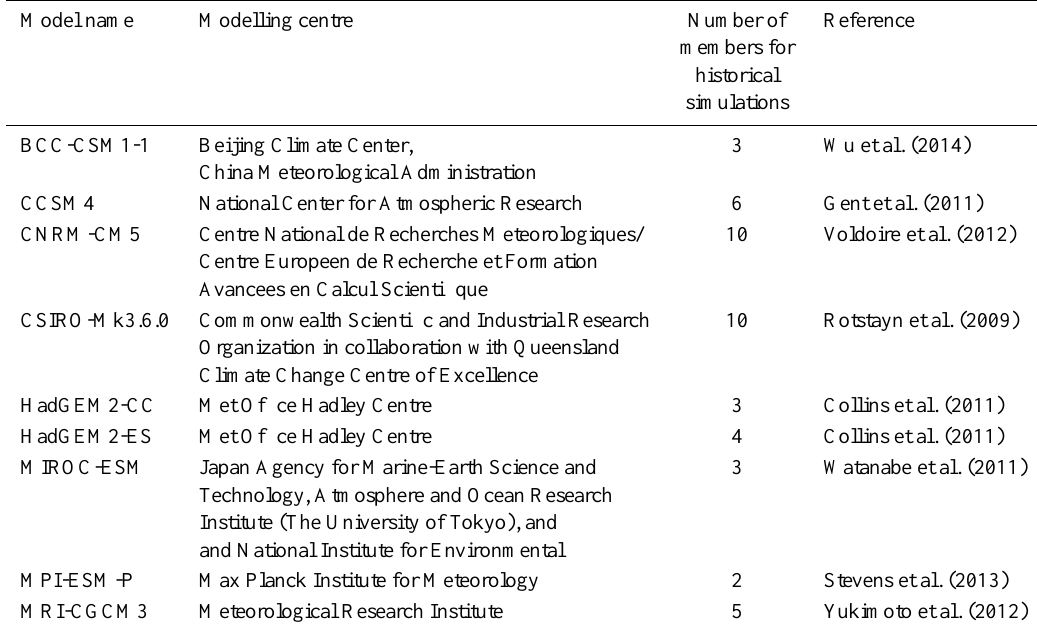
Table 1. CMIP5/PMIP3 GCMs characteristics and